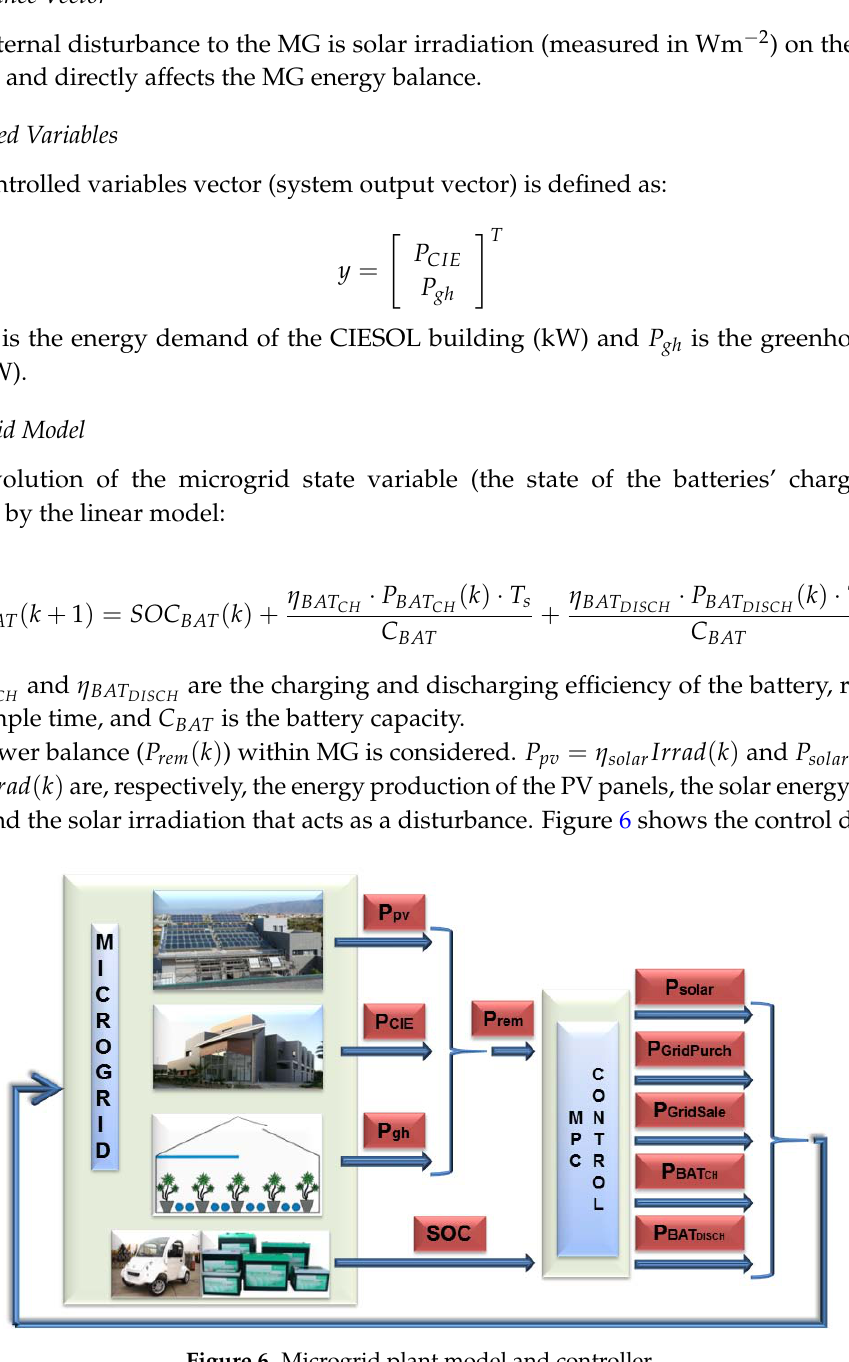
Figure 6. Microgrid plant model and